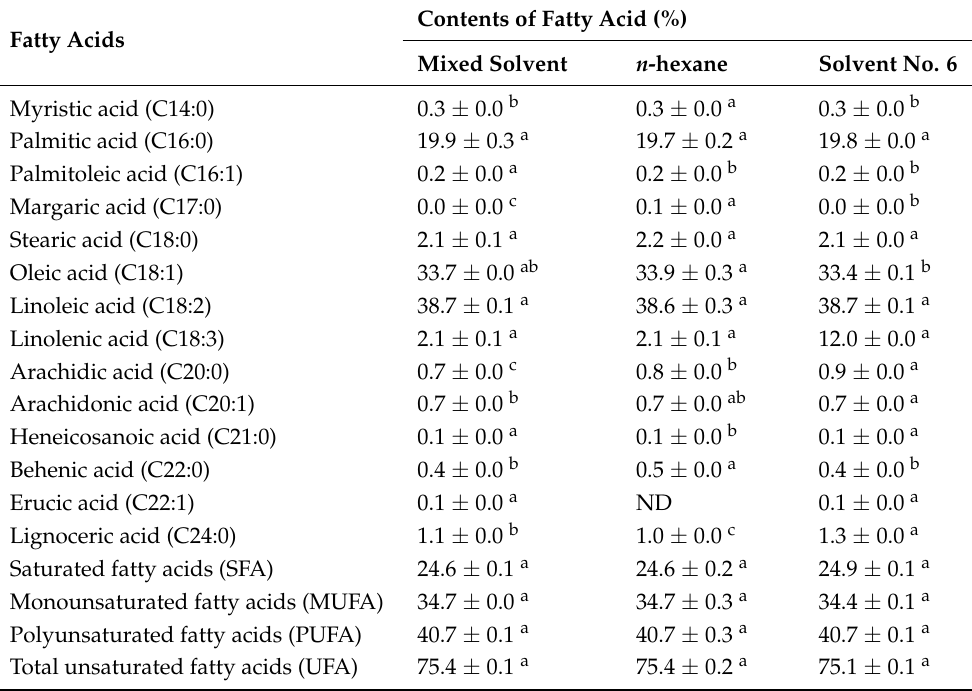
Table 5. Fatty acid composition and content of RBO extracted with different